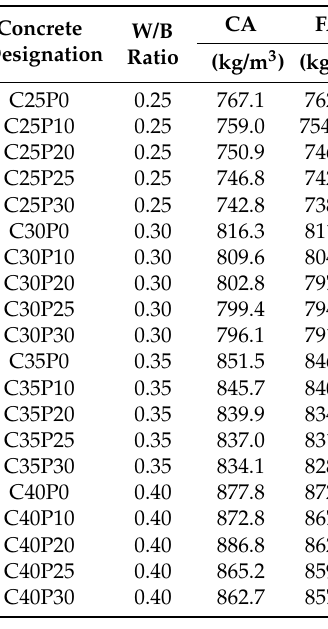
Table 2. Details of mix proportions for different SCHSC